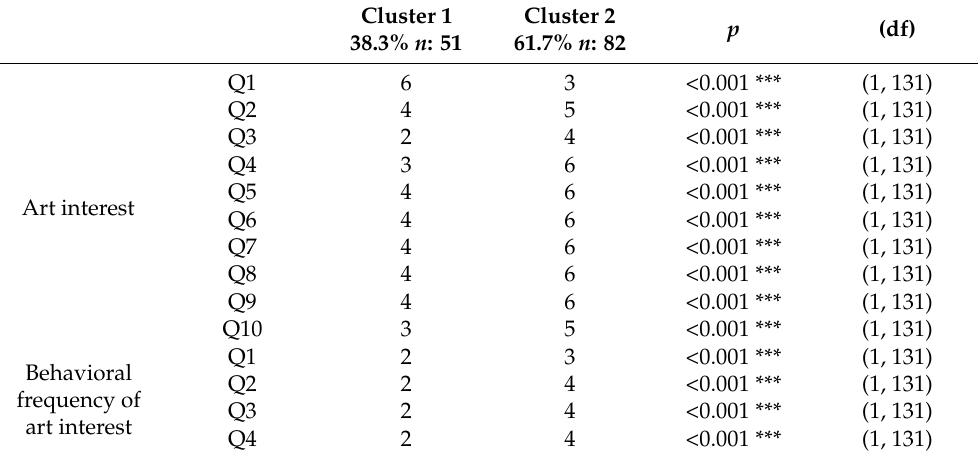
Table 6. Cluster analysis